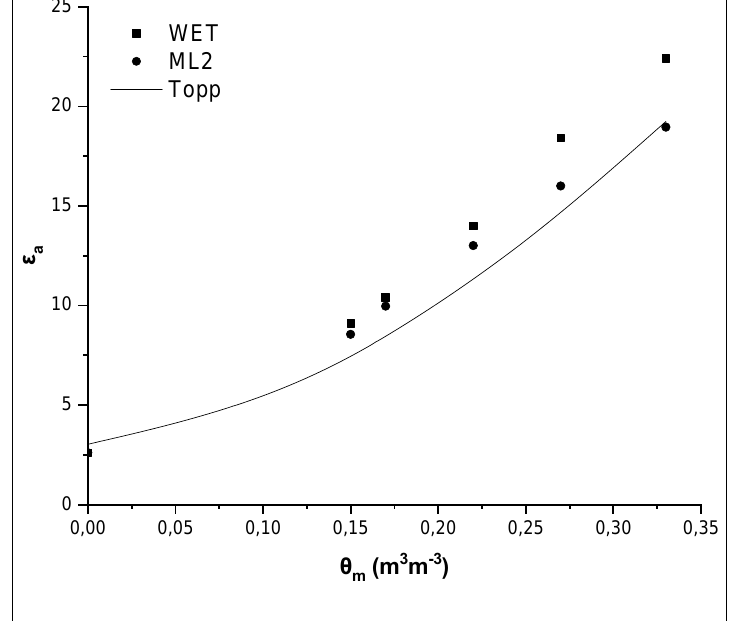
Figure 4. Comparative presentation of the relationships θ m - ε a obtained by the WET sensor, the ML2 sensor and the Topp equation for a sandy loam soil (SL) studied by Kargas et al. (2014) [6] with low iron content.